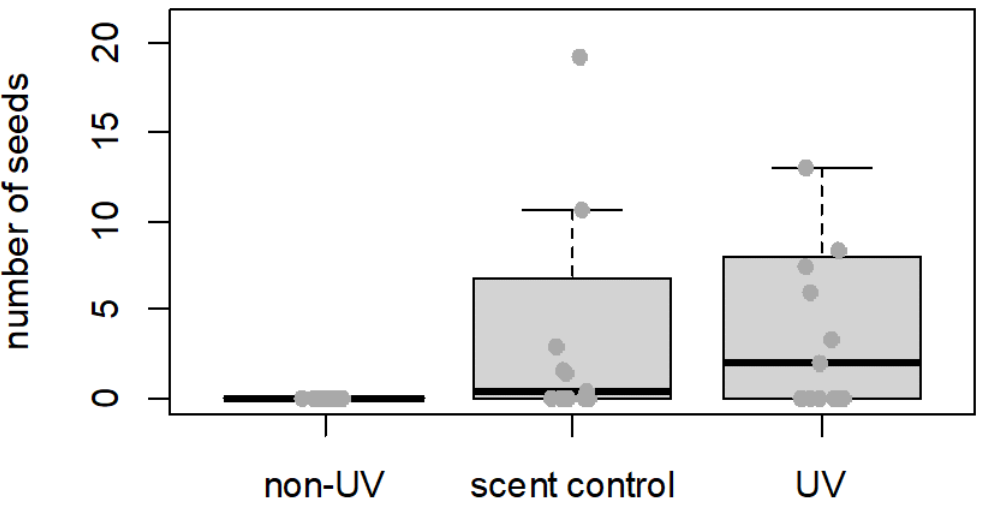
Figure 4. Average number of seeds per plant in Erica aristata without UV reflection, with UV-reflection and scent control (centre line, median; box limits, upper and lower quartiles; whiskers, 1.5x interquartile range), N =